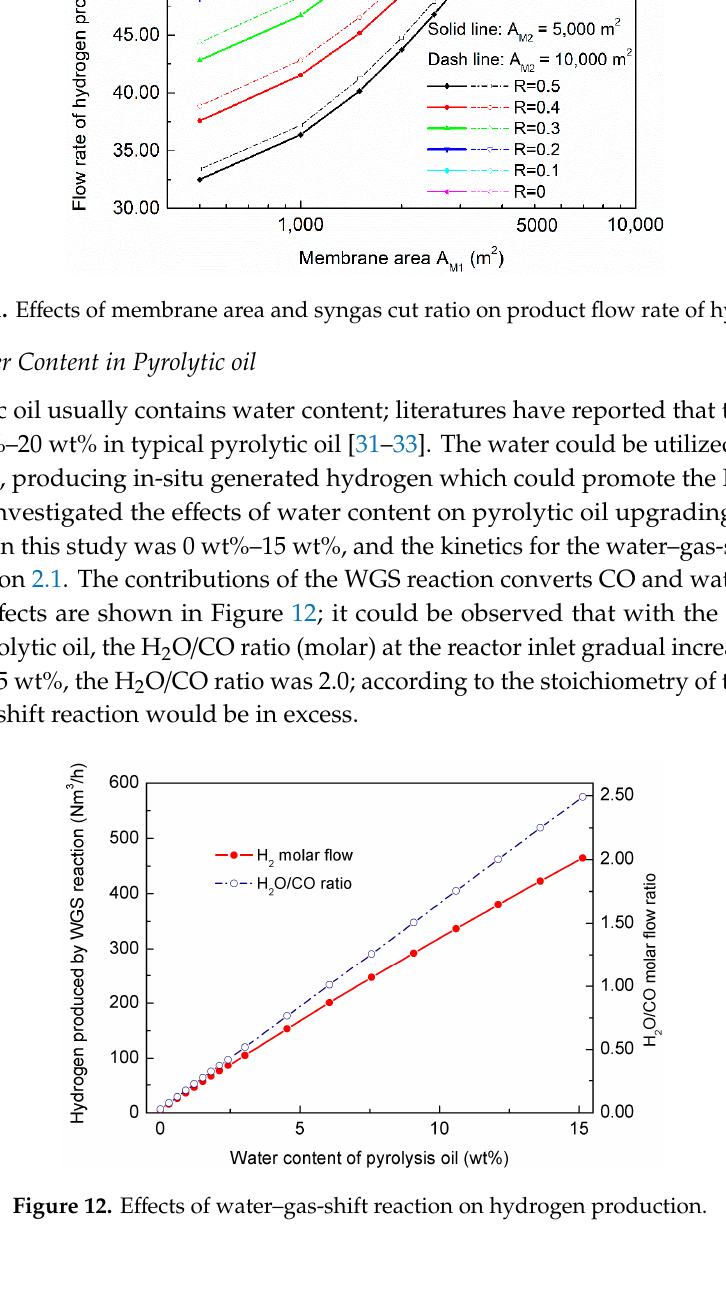
Figure 10. Influences of membrane area on hydrogen consumption. ( a ) Area of membrane-202 was 5000 m 2 ; ( b ) area of membrane-202 was 10,000 m 2 .